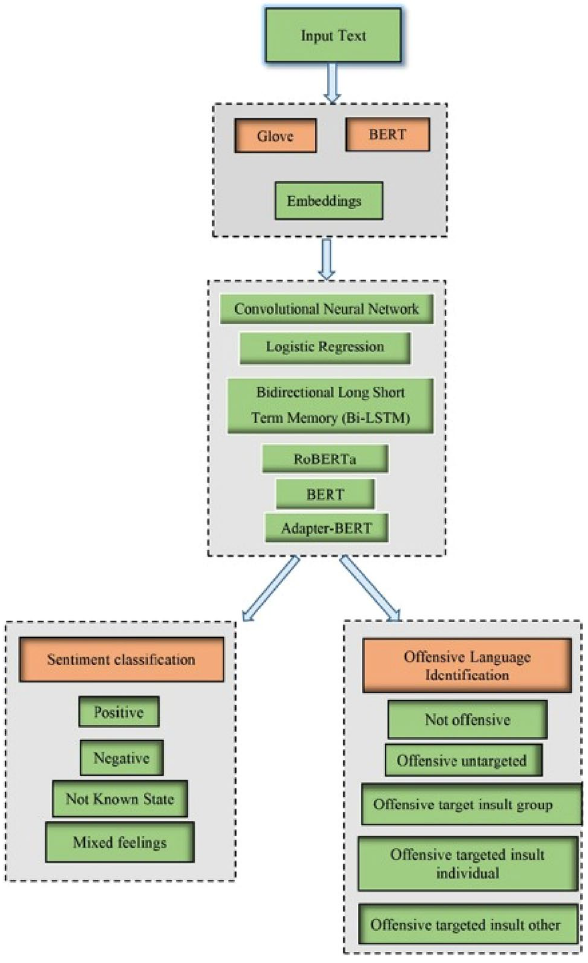
Figure 1. Proposed system